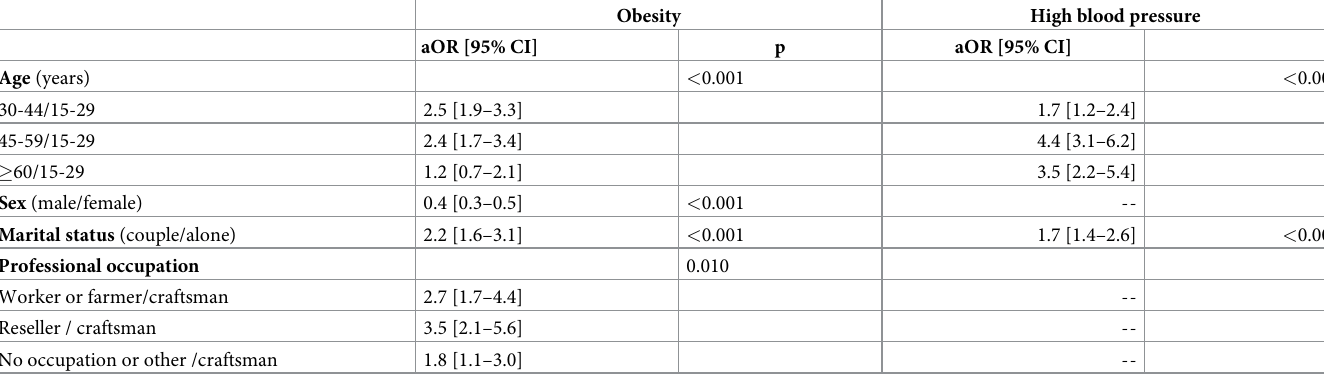
Table 3. Factors associated with obesity and high blood pressure, multivariable analysis, Parakou 2016.